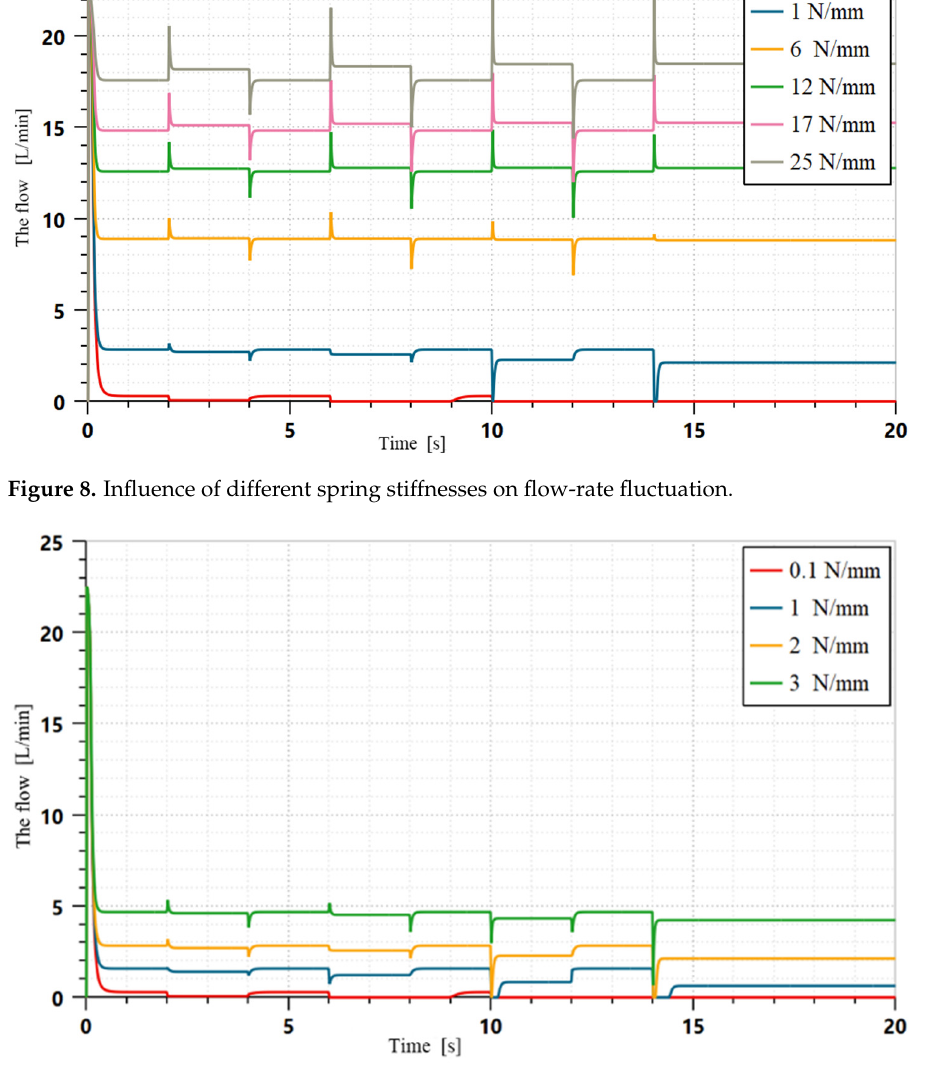
Figure 10. Flow rate changes when spring stiffness exceeded 12 N/mm. When the spring stiffness was more than 12 N/mm, compared with the flow-rate fluctuation of 3~12 N/mm in Figure 11, it can be seen that the flow-rate fluctuation was stable, its peak value was relatively large, and the flow rate changed with the change in the pressure difference. No longer meeting the basic requirements of the governor valve, the wave peak increased with the increase in the flow rate. To sum up, when the spring stiffness is preloaded with 0.1 N and the valve opening degree is 2 mm, it can be concluded that the range of the preloaded force should be within 3~12 N/mm and factors such as preloaded force and valve opening degree should be further optimized.